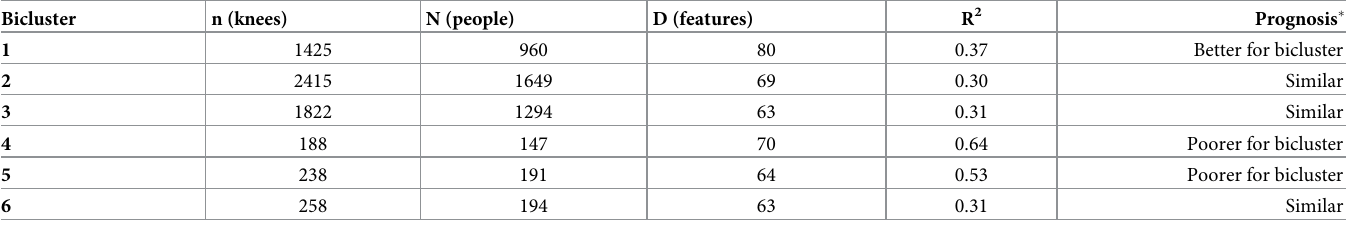
� Summary prognosis for those knees in each bicluster compared to the full cohort of knees, based on outcomes shown in Table 1, including knees without radiographic OA (rOA), knees developing incident rOA (baseline KLG = 0–1 increasing to 2+), knees with prevalent rOA (baseline KLG = 2+ without progression), knees with progressive rOA (baseline KLG = 2+ with worsening KLG), and the proportion of knees undergoing TKR over 96